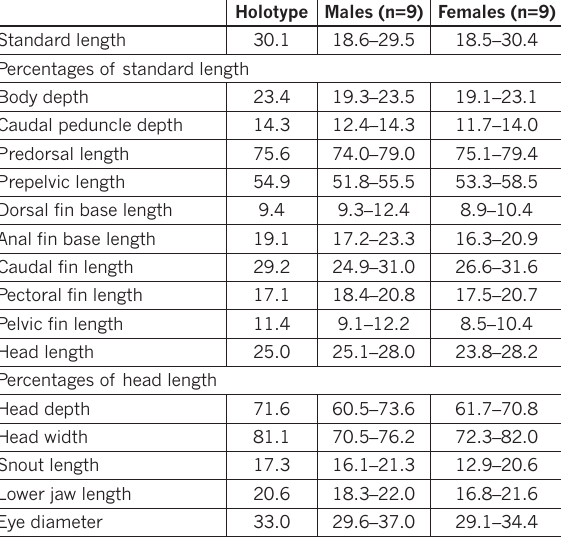
Table 2. Morphometric data for the holotype and paratypes of Melanorivulus ivinhemensis sp.